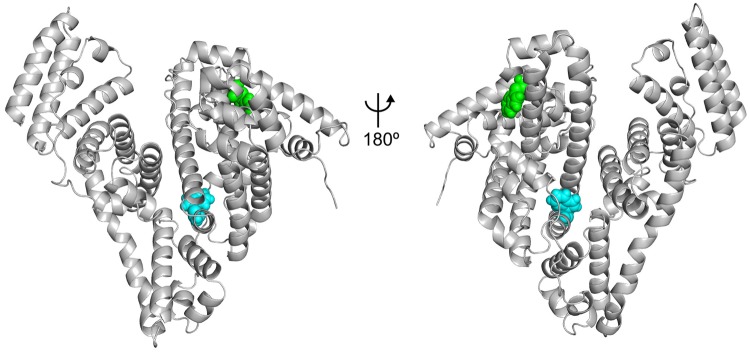
Location of the tryptophan residues on the structure of BSA.Residues Trp134 and Trp213 are represented as green and blue spheres, respectively.